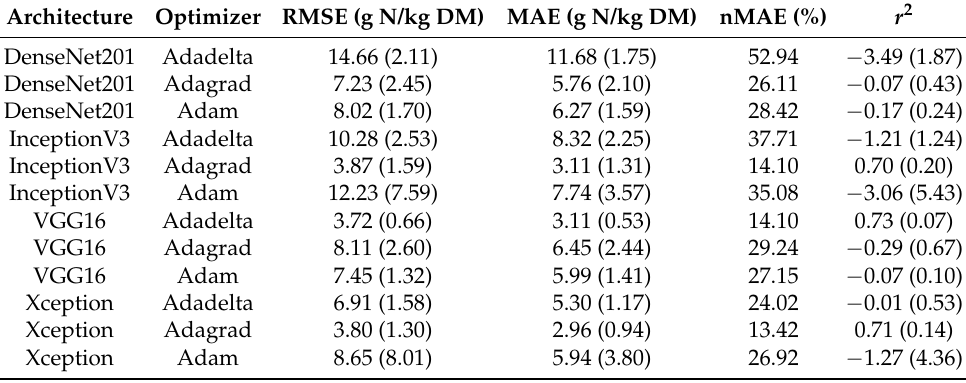
Table 5. Nitrogen concentration root mean squared error (RMSE), mean absolute error (MAE), normalized MAE (nMAE) and coefficient of determination ( r 2 ) means and standard values over the 8-fold test set for all the architectures and